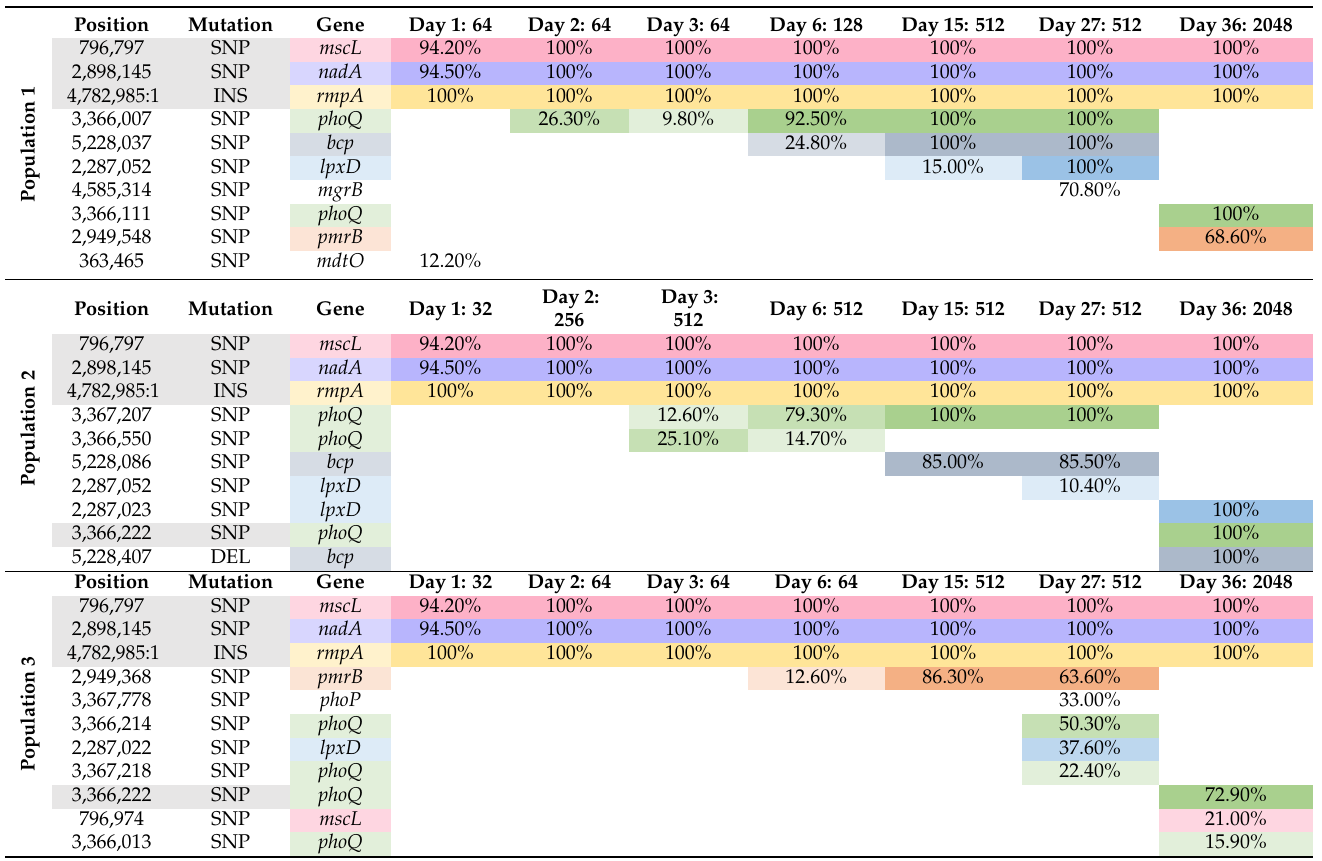
Table 1. Timepoint and MIC of acquired COL-R mutations in planktonic evolved KP populations. COL-R mutations are represented for each individually evolved KP population with colistin MIC ( µ g/mL) and population frequency. Mutations with shared gene positions between populations are shaded gray. Shared mutations in genes that are acquired in independently evolved populations are color-coded for comparison. Mutations unique to individual populations are in white background. The shading is darker for mutations with higher population